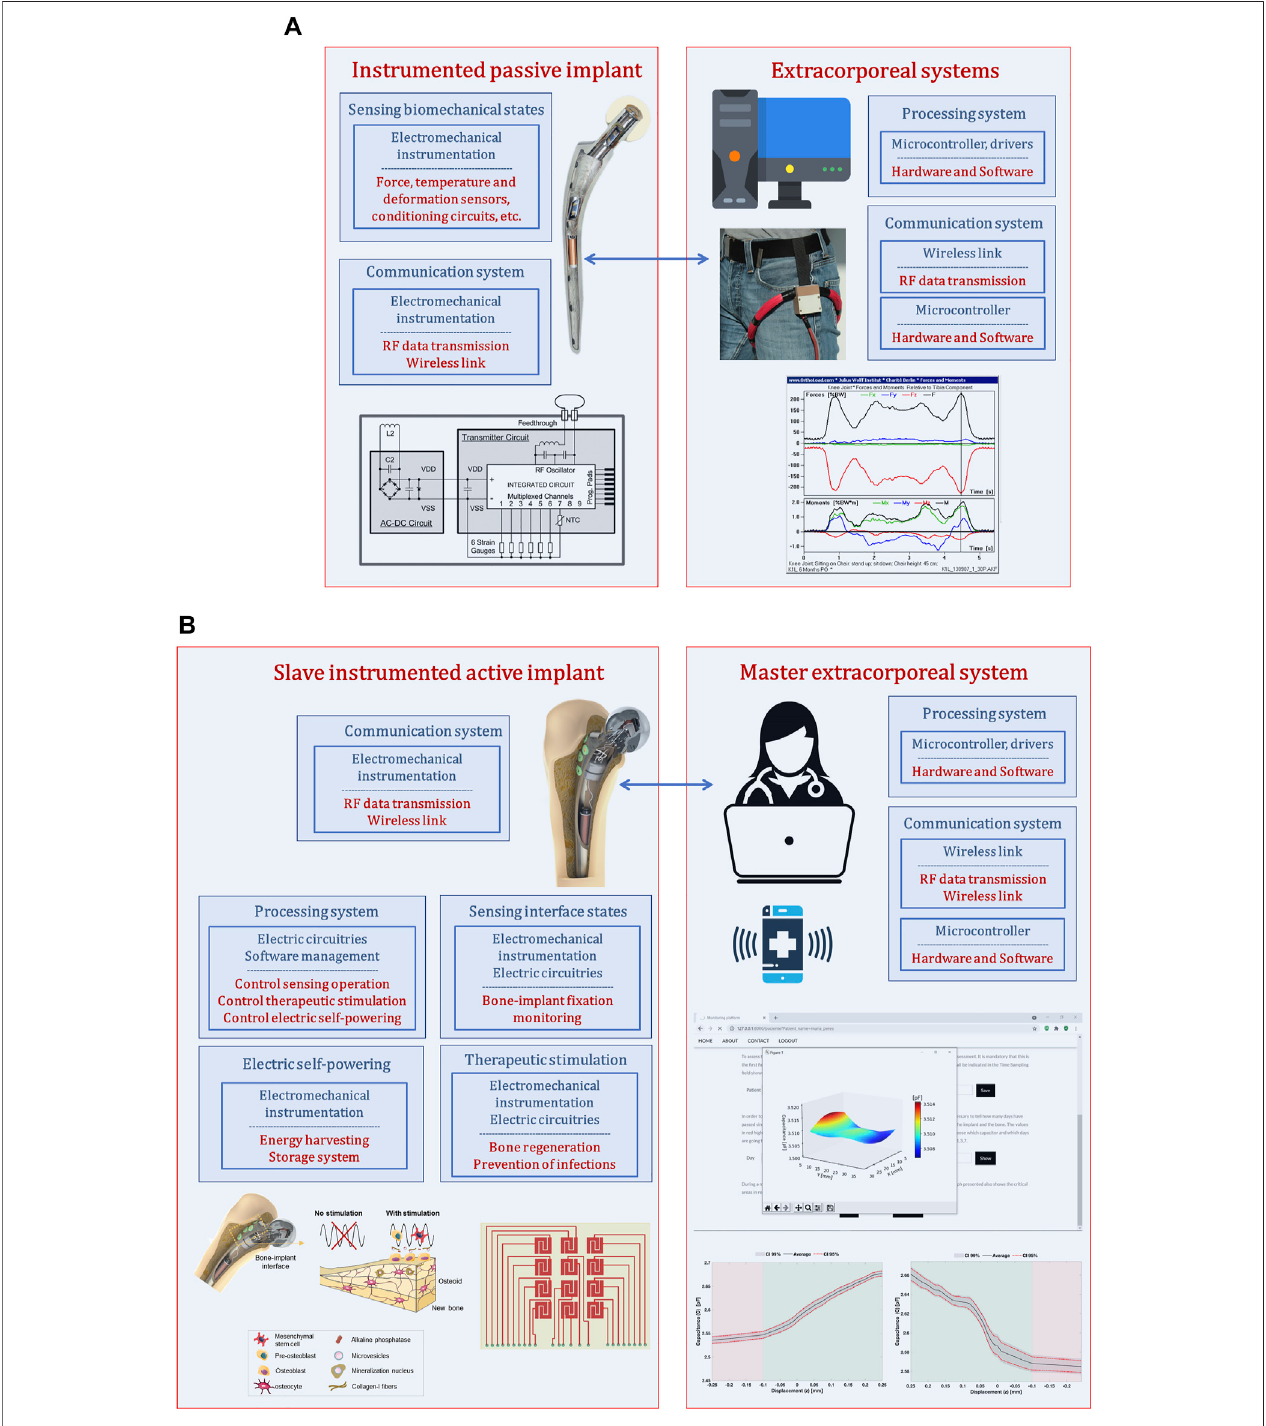
FIGURE 1 | (A) Architecture used to design instrumented passive implants (Soares dos Santos et al. (2015; 2014)); (B) Architecture used to design instrumented active implants as multifunctional smart devices (Soares dos Santos et al. (2019; 2015); de Sousa et al. (2021)).